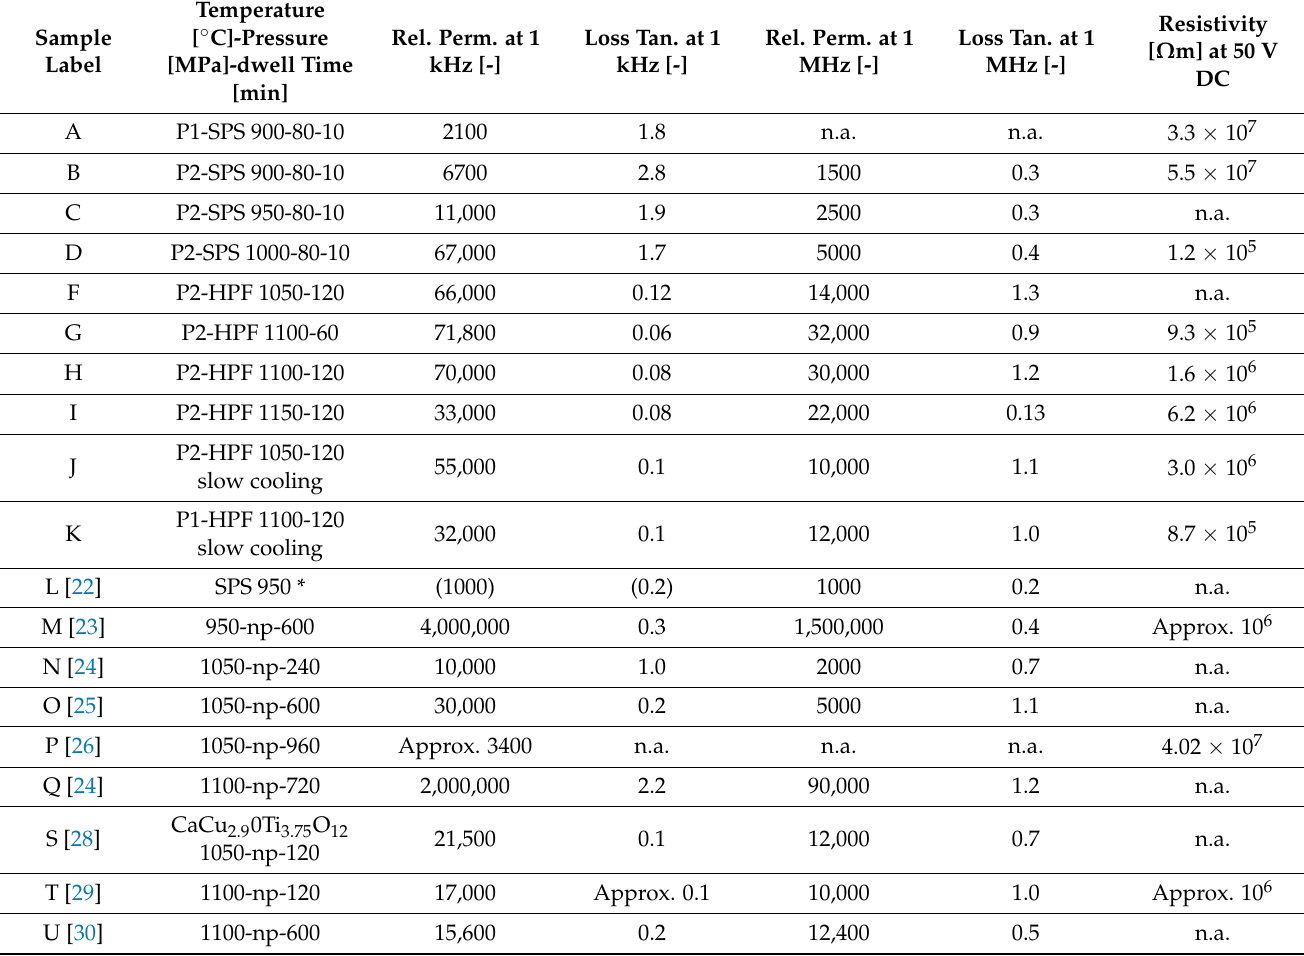
Table 4. Dielectric parameters,